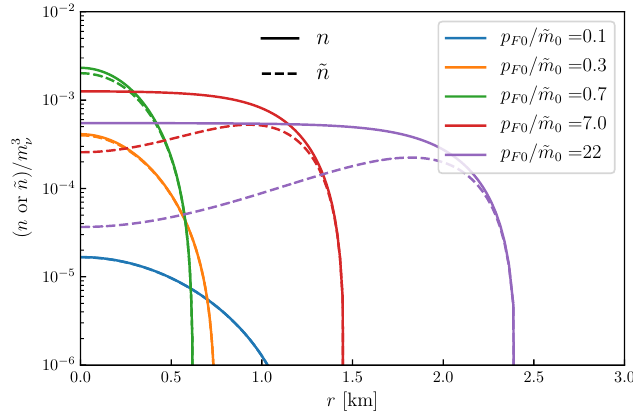
Figure 3 . The same as in figure 2 but for the relativistic case. Shown are the density (solid) and effective density (dashed) profiles for different values of p